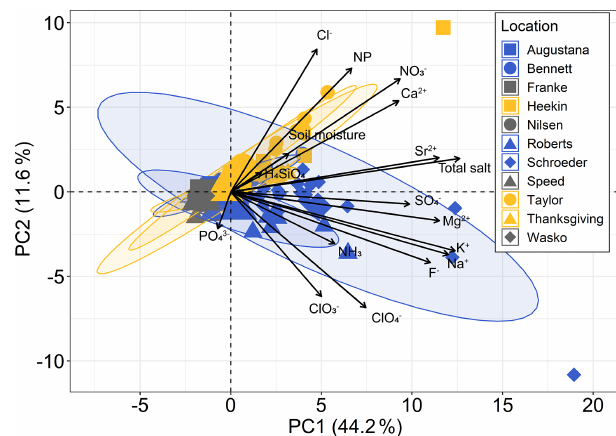
Figure 4. Principal component analysis (PCA) biplot generated in R using factoextra and built in R software libraries with all anions, cations, nutrients, and soil moisture for the three geographic zones. The PCA is based on the correlation matrix (i.e., scale = TRUE). Principal component 1 and principal component 2 are plotted on the x and y axes, respectively. Shaded ellipses represent 95% con- fidence intervals.